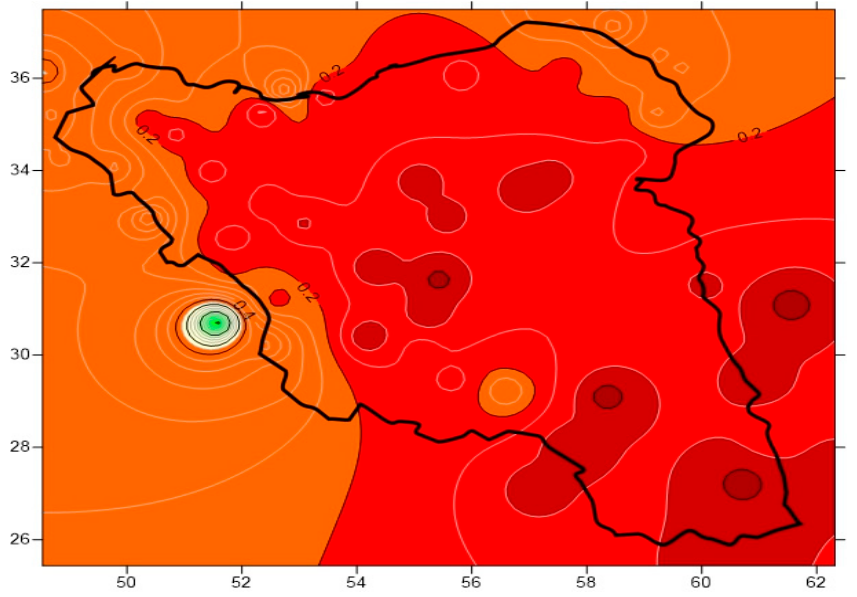
Figure 3. The spatial distribution of the zones with different aridity.